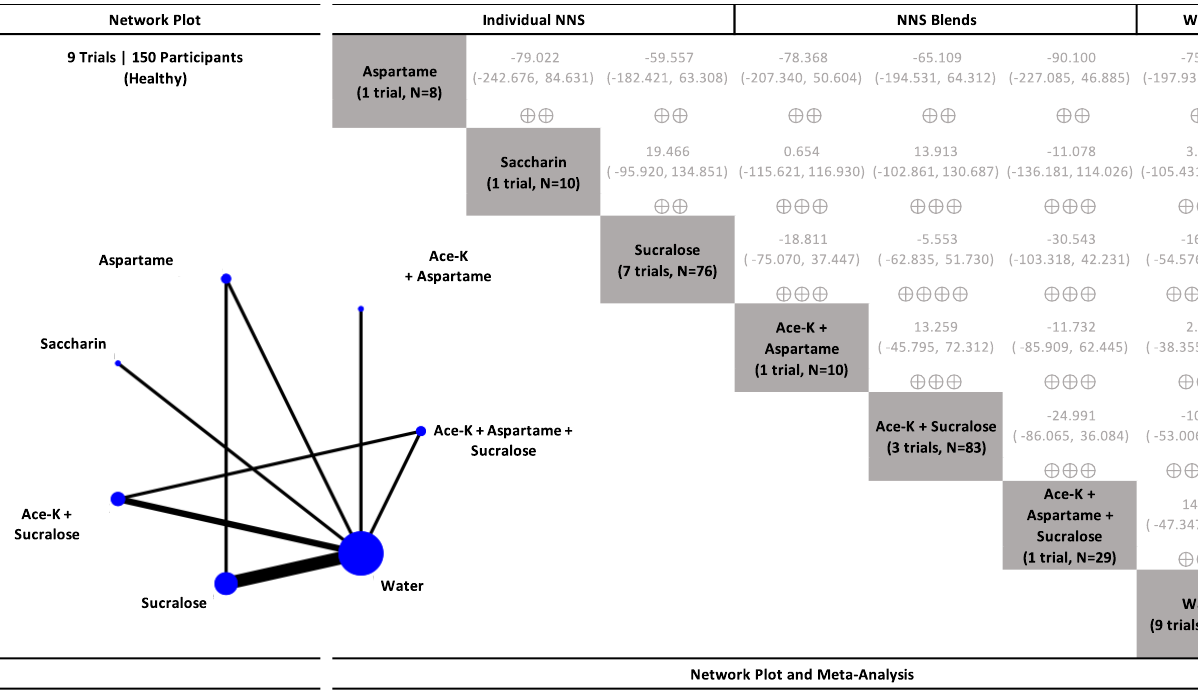
Figure 4. Network plot and meta-analysis of delayed coupling interventions evaluating the effect of non-nutritive sweetened beverages (NNS beverages) sweetened single or blends of non-nutritive sweeteners (NNS), water, and sugar-sweetened beverages (SSBs) sweetened with caloric sweeteners on postprandial blood glucose response in healthy participants. Network plot: the size of the blue nodes is proportional to the number of participants and the line width is proportional to the number of studies. Network table: treatments are grouped by treatment type (i.e., individual non-nutritive sweeteners (NNS), NNS blends, water, and caloric sweeteners) and are reported in alphabetical order. Treatment estimates (mmol*min/L) are MDs and 95% CIs of the column-defining treatment compared with the row-defining treatment. MDs less than 0 favor the column-defining treatment. MDs greater than 0 favor the row-defining treatment. Significant results are bolded in black. Non-significant results are grey and not bolded. The minimally important difference (MID) for postprandial glucose response is 100 mmol*min/L. Trivial (significant) effects (<1 MID) or no effects have a white background; small important effects (>1 MID) have a light blue background; moderate effects (>2 MID) have a darker blue background; large effects (>5 to <10 MID) have a purple background; very large effects (>10 MID) have a black background. Confidence in the effect estimate is shown for each treatment comparison: high confidence ⊕⊕⊕⊕ ; moderate confidence ⊕⊕⊕ ; low confidence ⊕⊕ ; very low confidence ⊕ . See Supplementary Table S17 and Figures S37 – S40 for detailed assessments of the confidence in the effect estimate using the CINeMA framework.